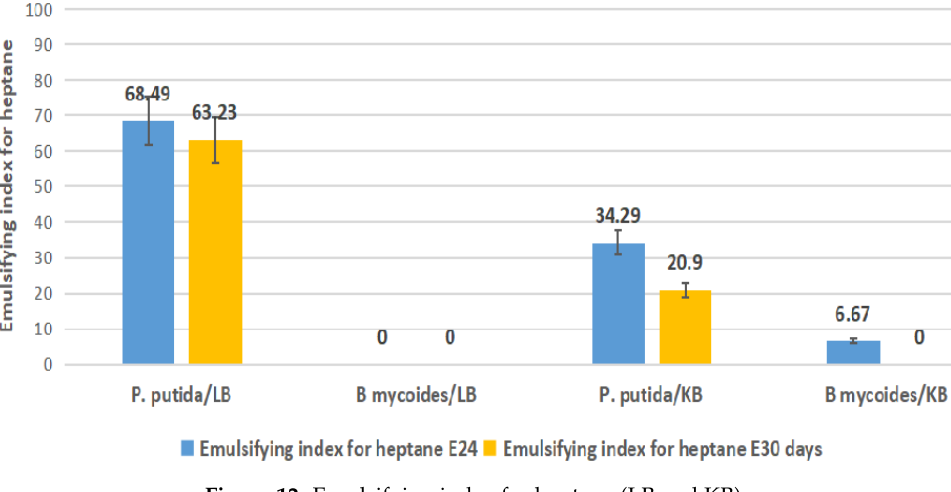
Figure 12. Emulsifying index for heptane (LB and KB).